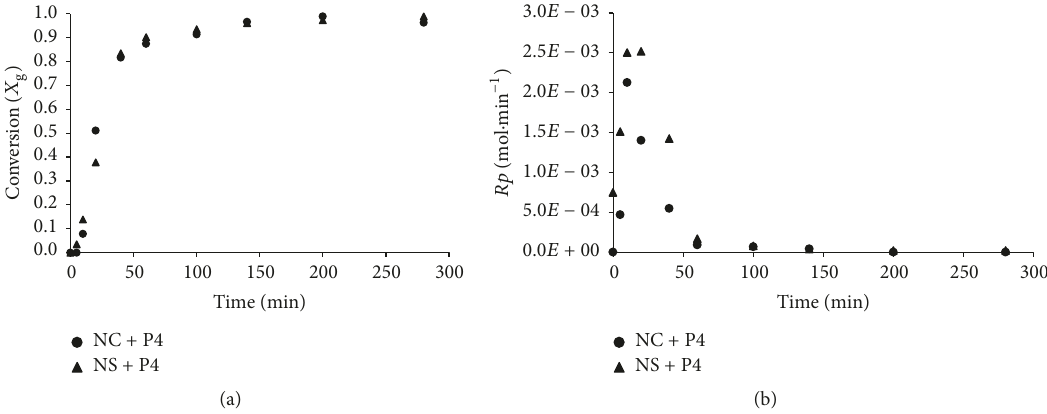
Figure 4: (a) Conversion and (b) reaction rate (Rp) during miniemulsion polymerization for the formation of PMMA NC (nanocapsules) and NS (nanospheres) using 1mg